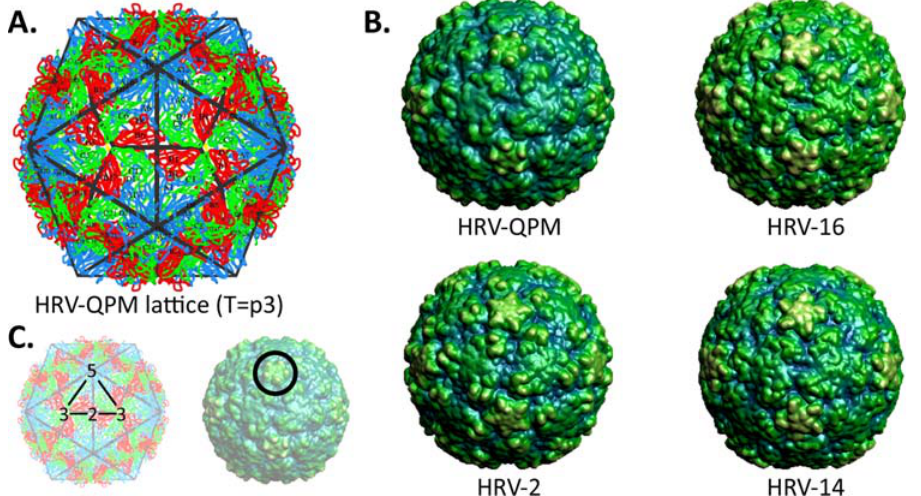
Figure 5. Predicted virion capsid structures. (A) Replication ( 6 60) and mapping of the predicted HRV-QPM protomer onto a T=1 icosahedral lattice (representing T=p3 configuration). (B) 3D rendering of predicted HRV capsids providing imagery similar to that obtained by cryo-electron microscopy reconstruction at 10 A˚ resolution. HRV-2, -14 and -16 predicted structures were derived from crystallography data. Each viral capsid has been depth cued to demonstrate canyon structure; yellow indicates surface detail and blue identifies areas of greatest depth. (C) Numbers superimposed over the lattice indicate the fold axis. The simplified position of the canyon is indicated by a circle on the capsid. All models were rendered and oriented identically, as determined by VIPERdb [59].